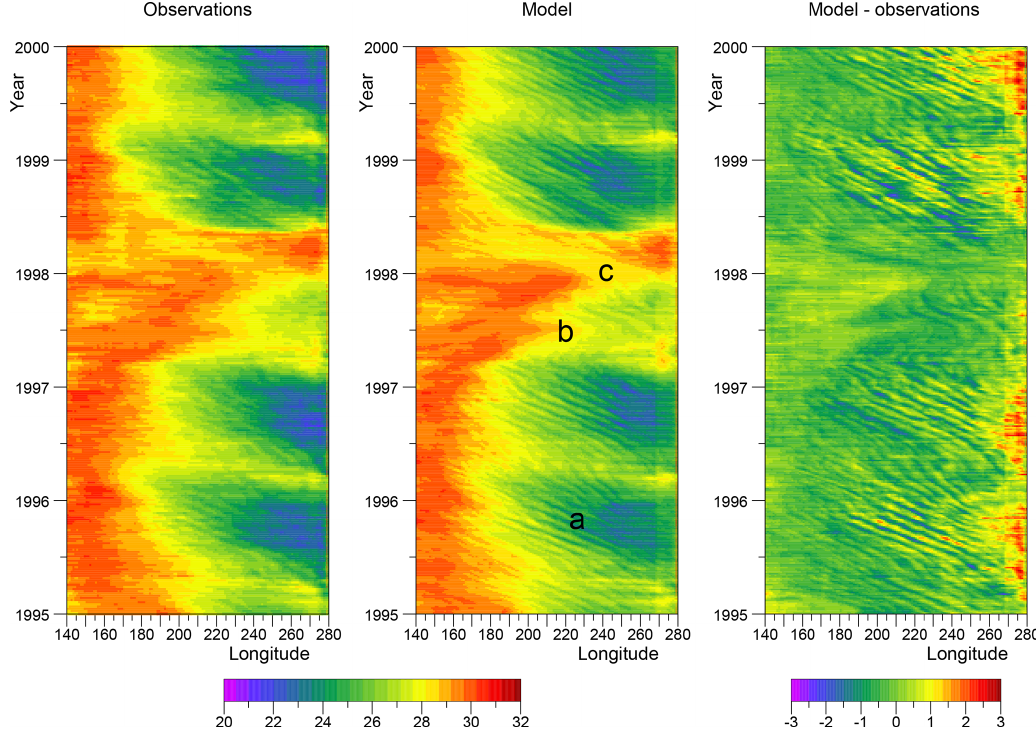
Figure 1. Observed and model sea surface temperatures and their difference, averaged between 5 ◦ S and 5 ◦ N, for the equatorial Pacific between 140 and 280 ◦ E (80 ◦ W), showing (a) tropical instability waves, strongest in the second half of non-El Niño years; (b) initial mid- ocean El Niño, discussed in Webb (2018); and (c) strong El Niño, starting in the west around mid-year and arriving in the east around new year. Temperature units are degrees